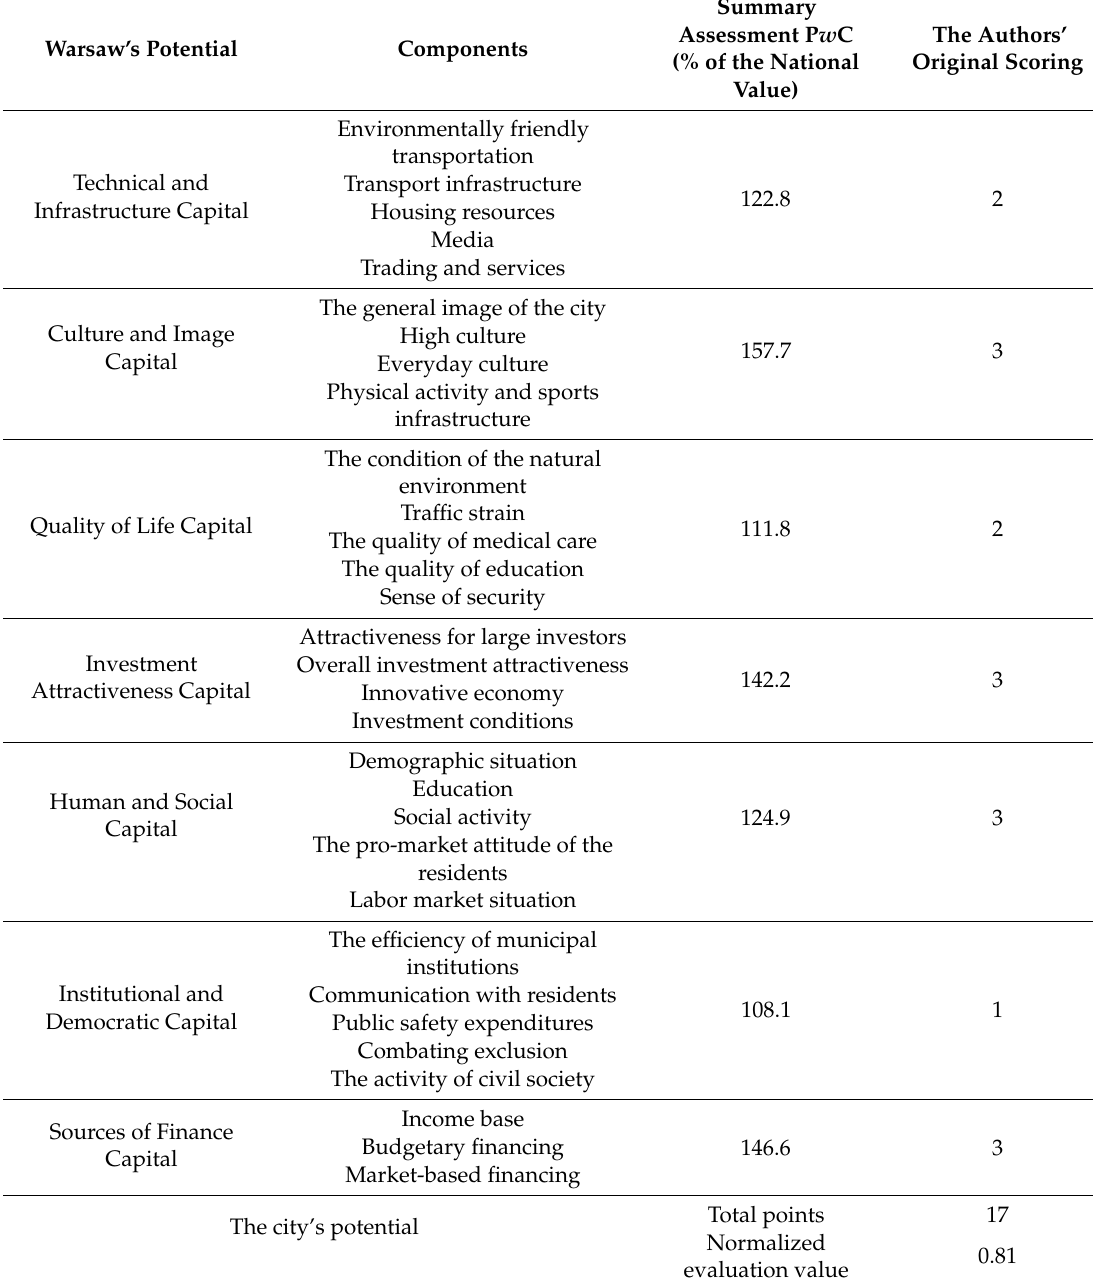
Table 6. Assessment of features of the city’s potential. The evaluation of Warsaw’s potential (based on P w C’s analysis, 2019, with authorial